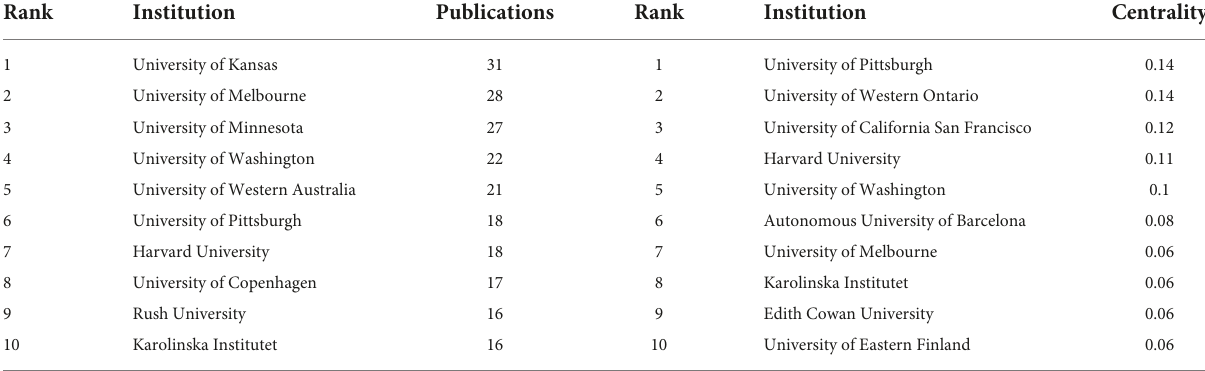
TABLE 2 Top 10 most productive